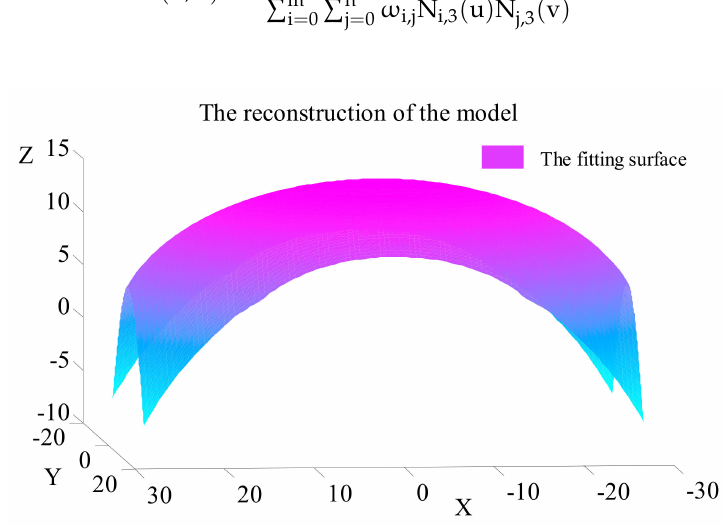
Figure 6. The reconstruction of the model.